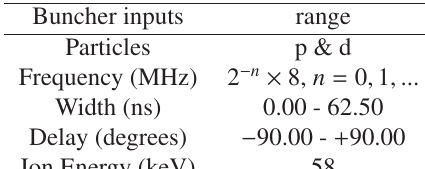
Figure 2. Schematic layout of the pulsed system installed on the Tandem accelerator, with the chopping (light blue) and the bunching (dark blue) elements.